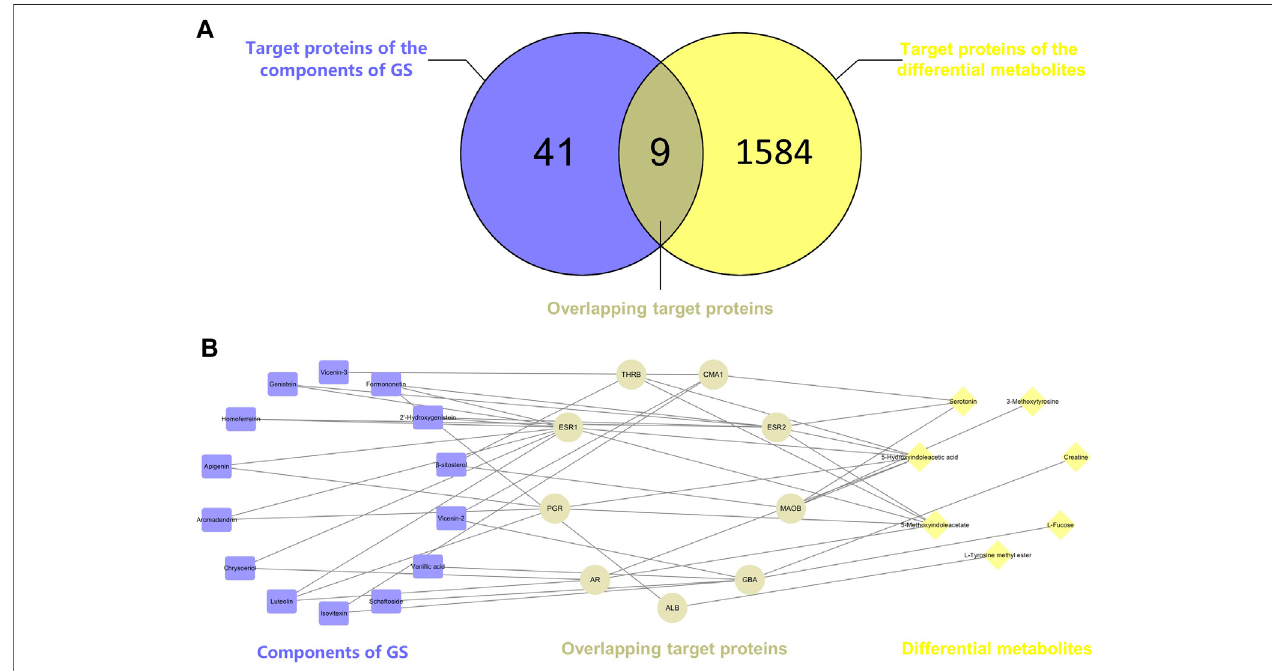
FIGURE 7 | (A) Venn diagram. The intersection of two circles represents the overlapping target proteins of the components of GS and the differentially altered metabolites. (B) Thecomponent-target-metabolitenetworkinthetreatmentofoxalate-induced kidneyinjurybyGS.Thepurplenodes(14)represent thecomponentsof GS, the yellow nodes (C) represent the differentially altered metabolites, and the gray nodes (D) represent the overlapping